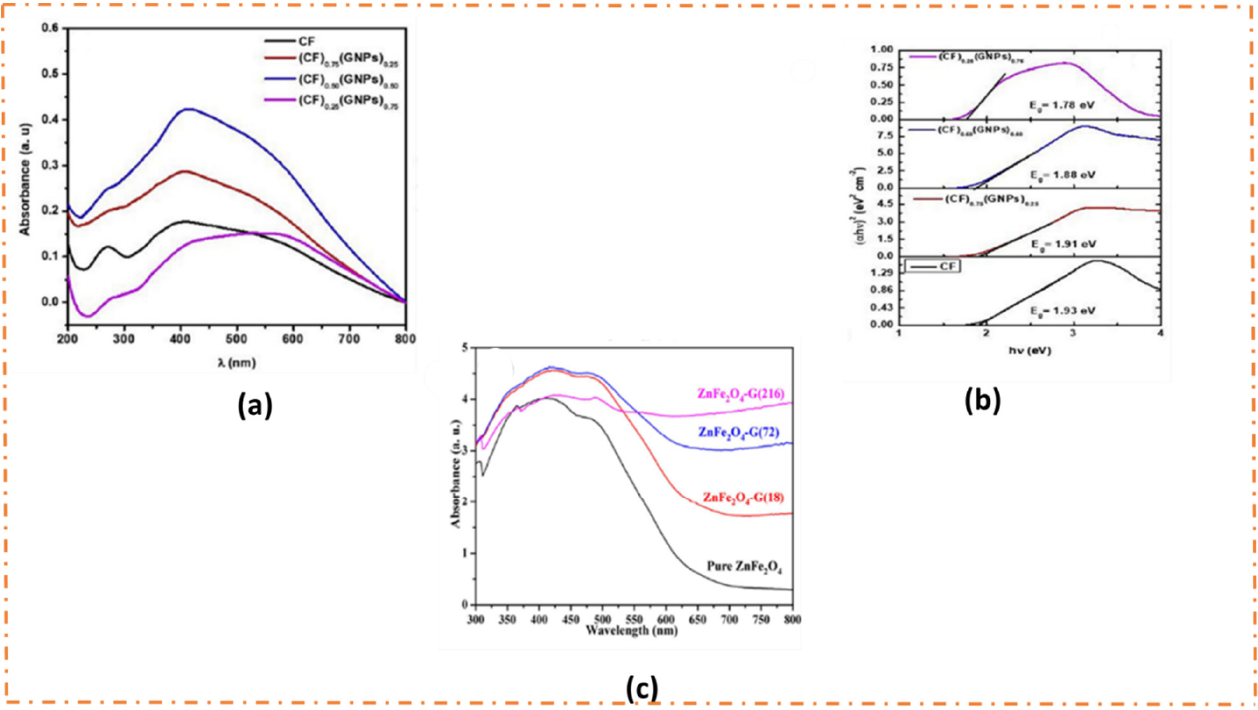
Figure 4. ( a ) UV–visible absorbance spectra and ( b ) Tauc plots for pristine CaFe 2 O 4 and CaFe 2 O 4 /gra- phene composite with different amounts of graphene “Reprinted/adapted with permission from Ref. [51]. 2021, Elsevier”. ( c ) UV–visible diffusive reflectance spectra of ZnFe 2 O 4 /rGO composite “Reprinted/adapted with permission from Ref. [52], 2020,